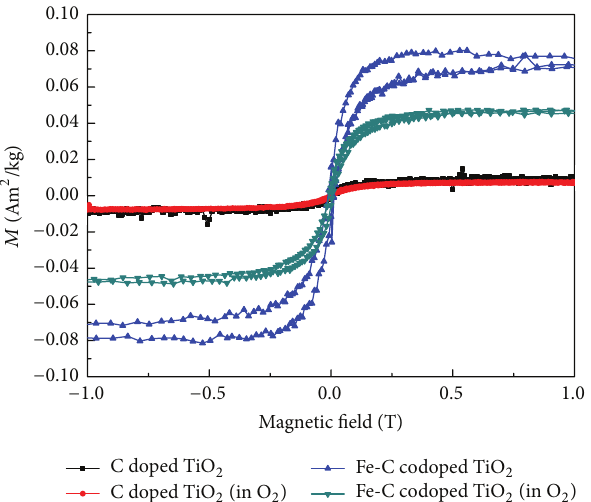
Figure 4: Hysteresis loops of the C doped TiO 2 films, C doped TiO 2 films (annealed in O 2 ), Fe-C codoped TiO 2 films, and Fe-C codoped TiO 2 films (annealed in O 2 ) at